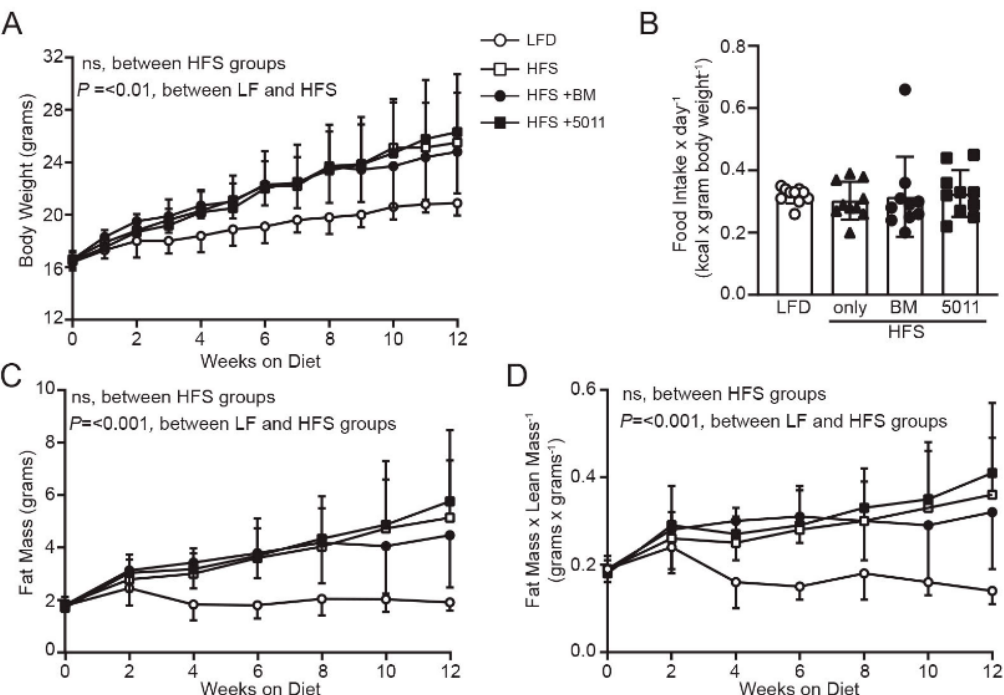
Figure 1. High-fat, high-sucrose (HFS) diet results in weight gain and increased adiposity independent of food intake or dietary supplementation with botanical extracts. Body weight ( A ) increased in the HFS groups versus low-fat (LF)-fed controls but did not differ between HFS groups. Food intake ( B ) did not differ between groups. Fat mass ( C ) was elevated in all HFS groups compared to LF-fed mice, but did not differ between the HFS-fed groups. Fat mass/lean mass ratio ( D ) was decreased in the LF group compared to that in all HFS groups, which did not differ from each other. ( n = 10 per group), statistical significance was set at p < 0.05. Variability is expressed as mean ± SD.